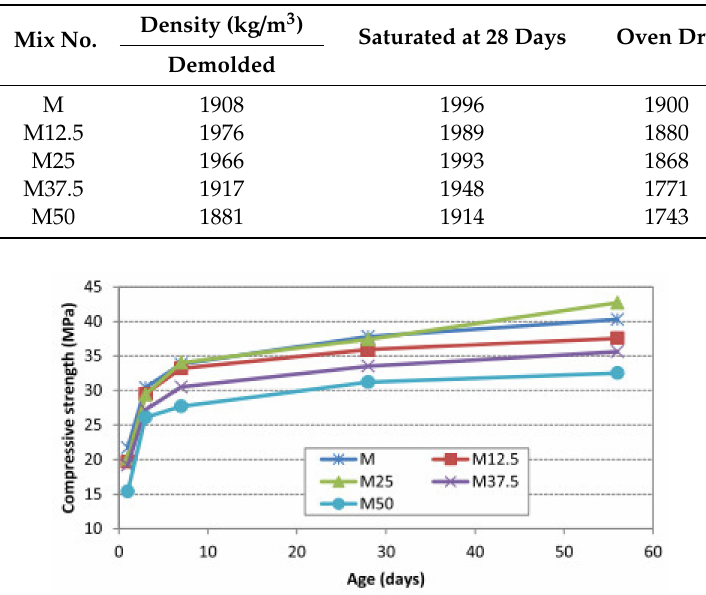
Table 1. Density of concrete [50], with copyright permission from Elsevier.